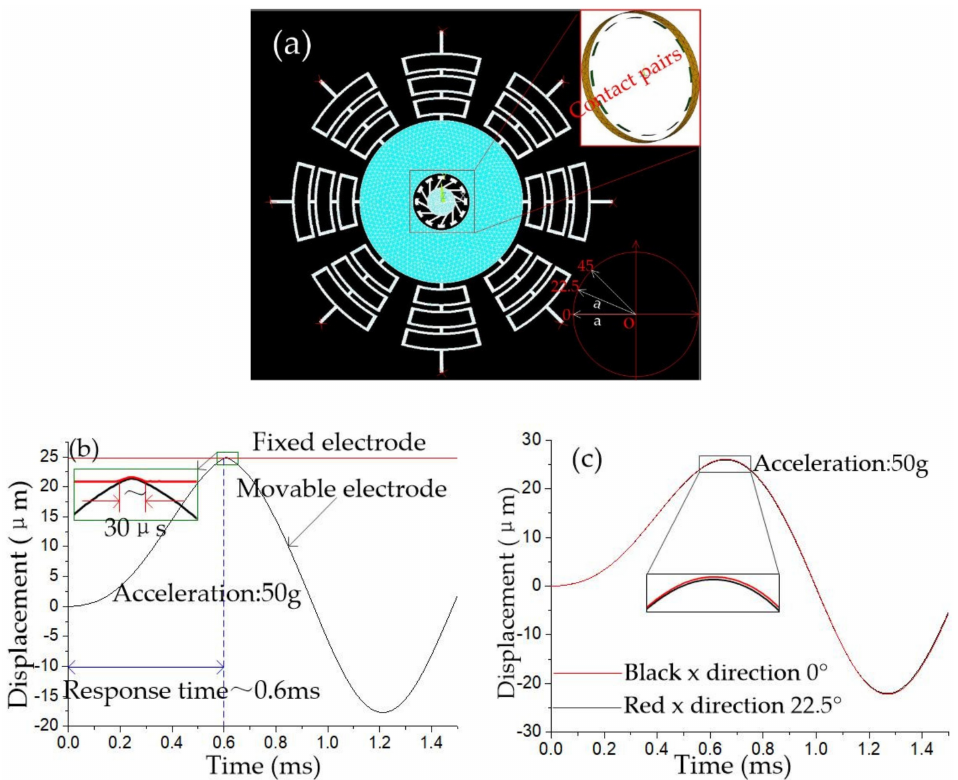
Figure 4. ( a ) FE model of the designed inertial switch; ( b ) The dynamic contact process in sensitive direction; ( c ) The dynamic contact process in the 0 ◦ and 22.5 ◦ directions.